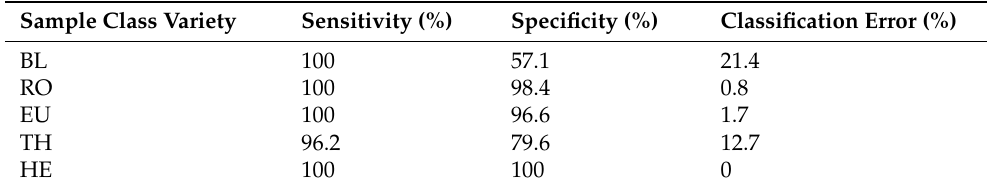
Table 1. Multiclass predictions by cross-validation for the set of blossom-honey samples using three LVs. BL: orange/lemon blossom; RO: rosemary; EU: eucalyptus; TH: thyme, and HE: heather. Sample Class